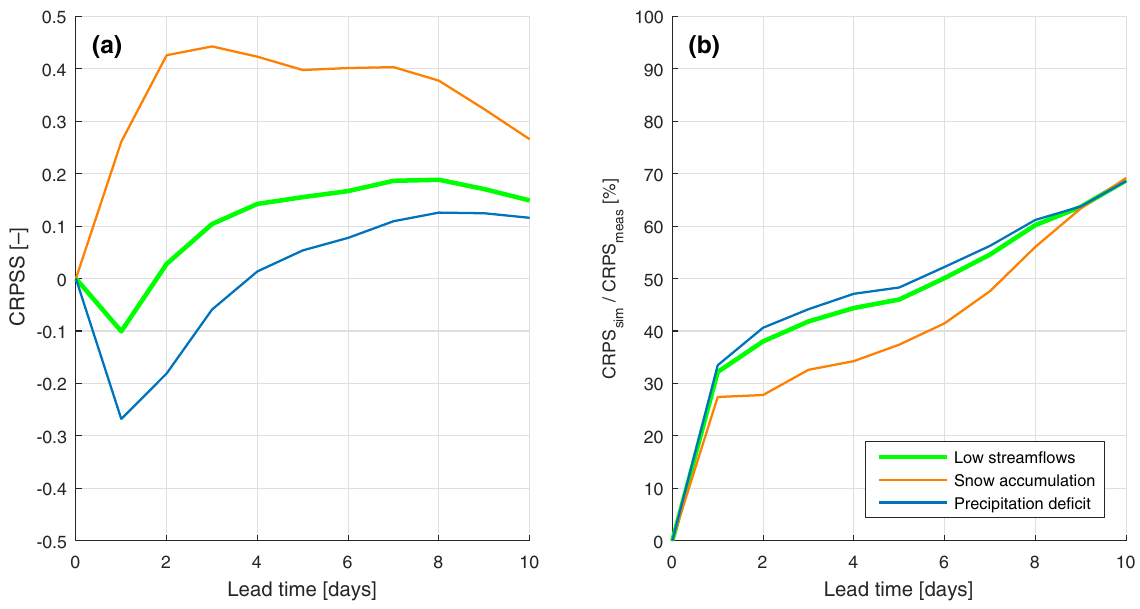
Figure 10. (a) Forecast skill of low-streamflow-generating processes. (b) Ratio of errors in meteorological forecasts (CRPS sim ) to meteoro- logical forecast + model errors (CRPS meas